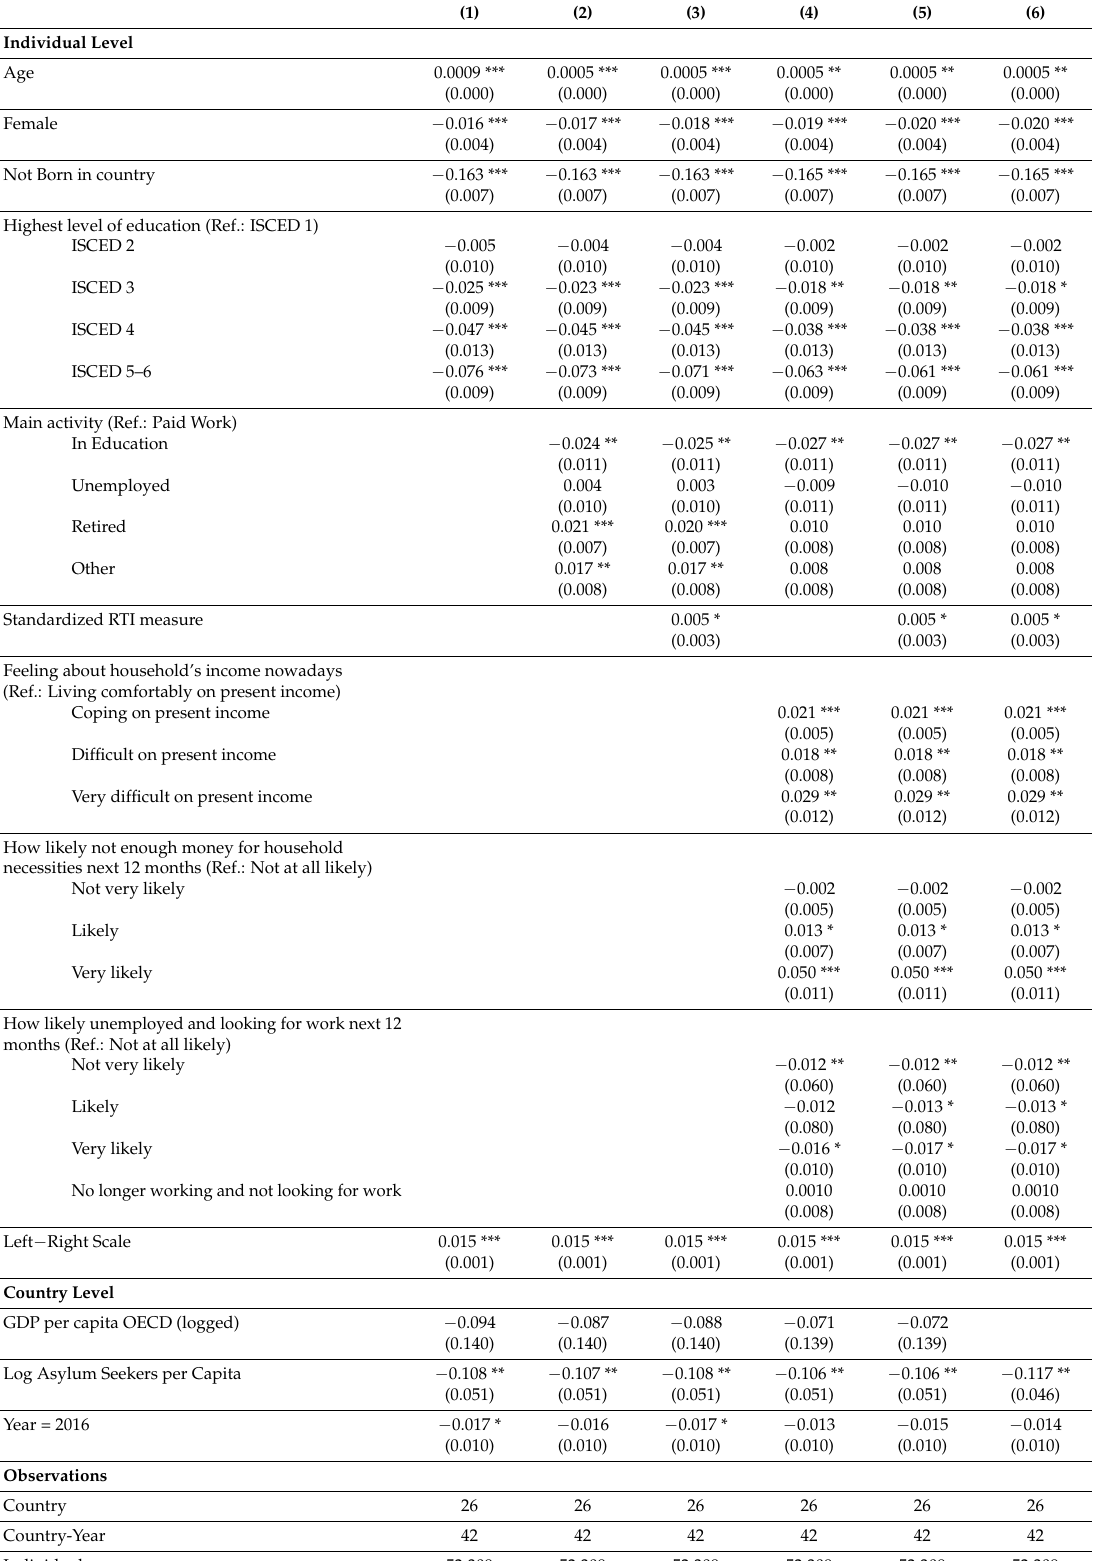
Table 3. Welfare Chauvinism, Binary Logit